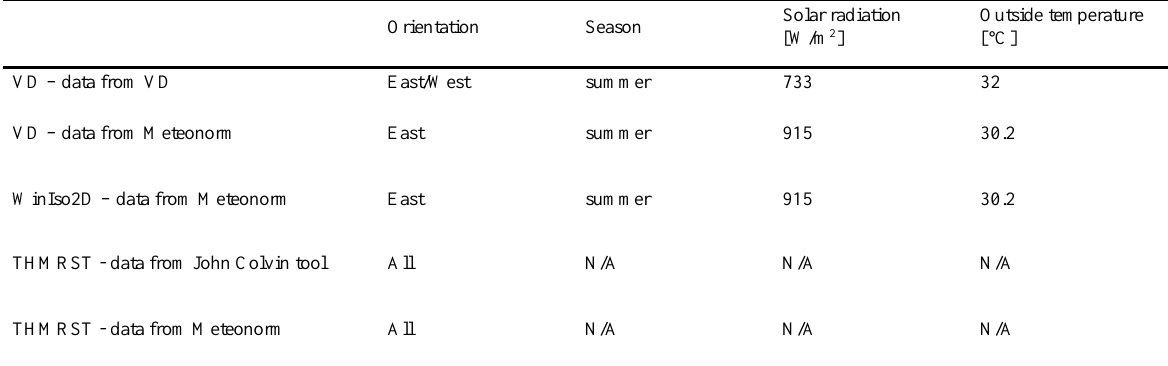
Table 3: THE MOST CRITICAL CLIMATIC DATA FOR PANE 1 for max. temperature